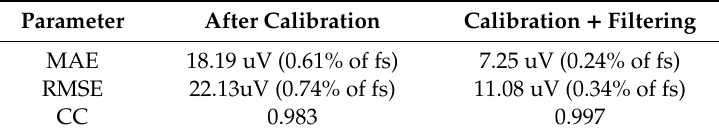
Table 5. Setup for clients running ECGView